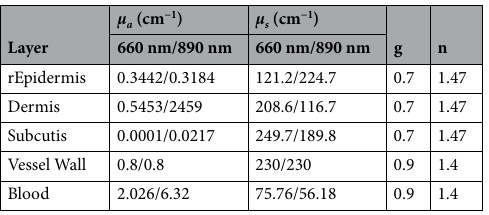
Table 2. Optical properties at two corresponding wavelengths.